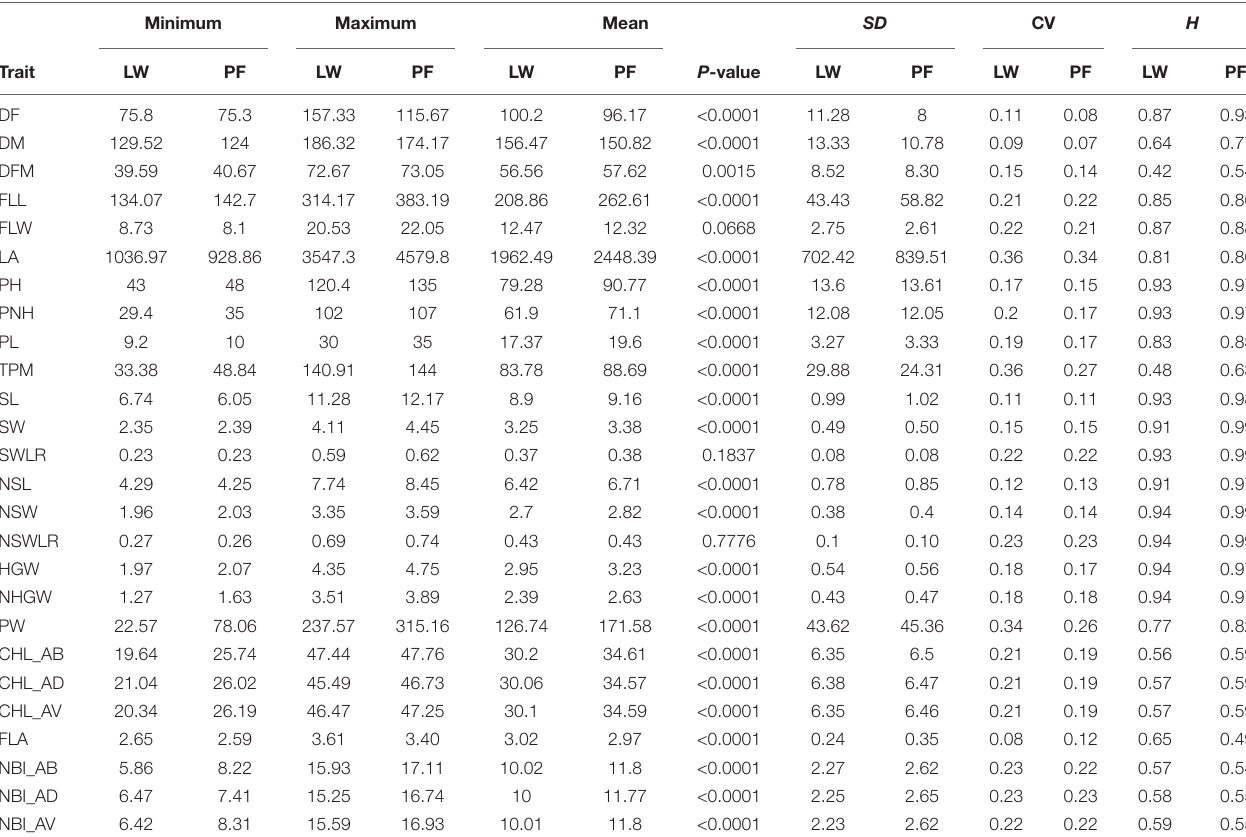
TABLE 2 | Summary statistics for the traits evaluated in LW and PF.